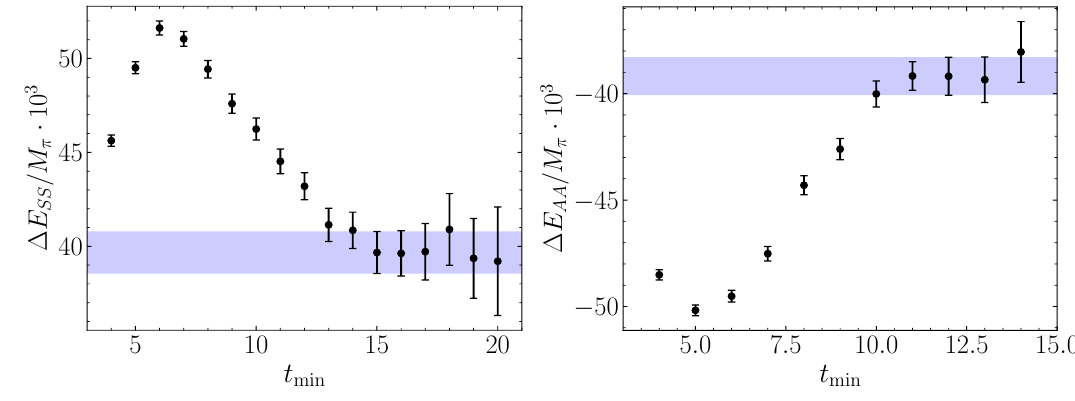
Figure 4 . Examples of the energy shift determination for the two channels and different ensembles: 4A20 for the SS channel (right) and 6A10 for the AA channel